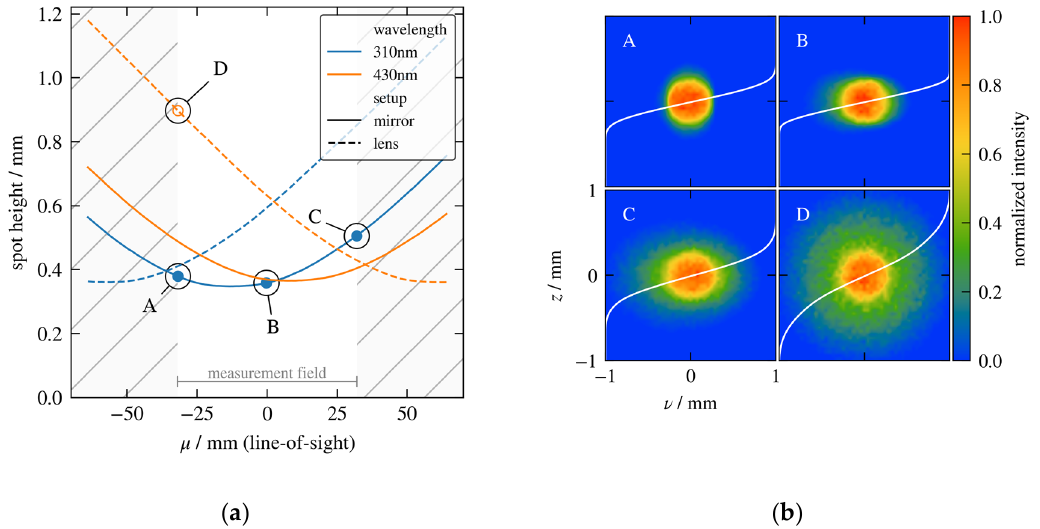
Figure 4. ( a ) Variation of the out-of-plane resolution (spot height) over the measurement field (line-of-sight direction) at 310 and 430 nm for a telescope with two lenses (dashed lines) or with a lens and tilted spherical concave mirror (solid lines). ( b ) Intensity distributions of the imaged spots and normal to the line-of-sight direction at selected positions A, B, C, and D. The white lines are cumulative probability density curves along the z -axis. See the text for the definition of the coordinate systems.